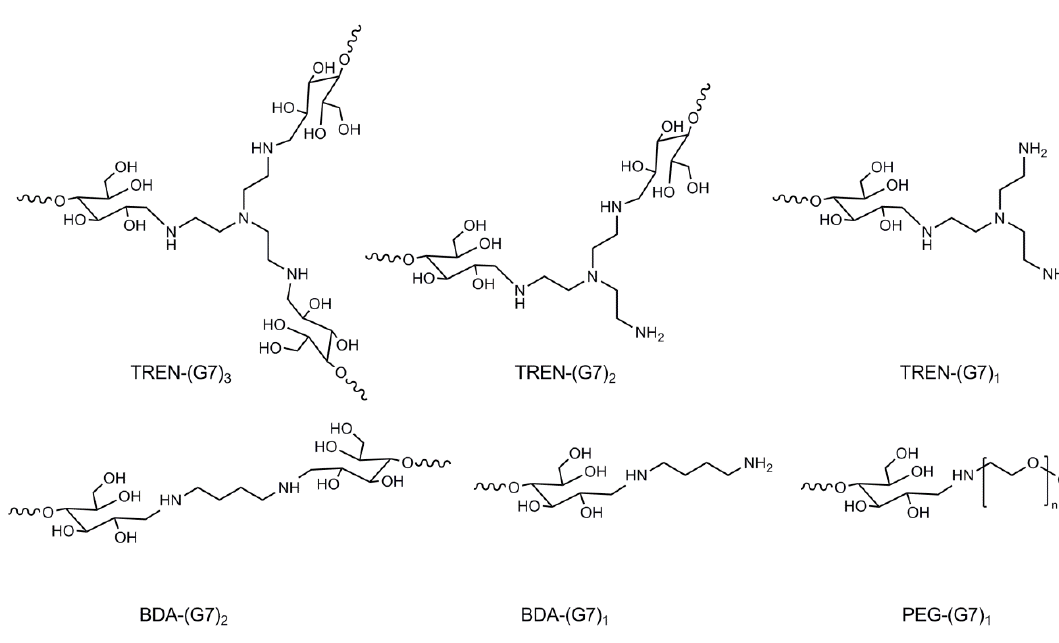
Figure 5. The different reaction products after reductive